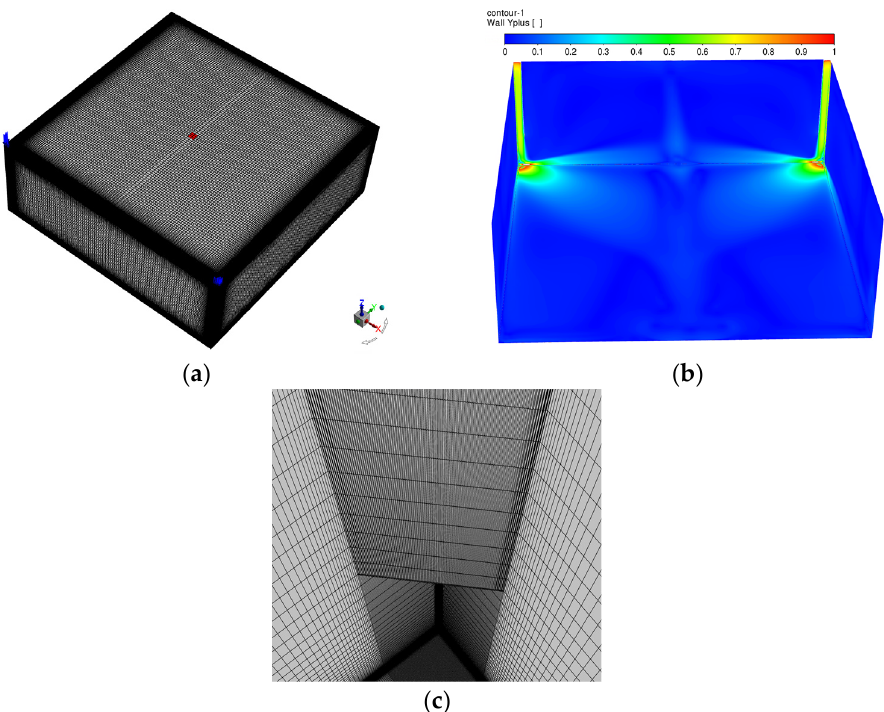
Figure 1. ( a ) Shows a perspective view over the room mesh where the two inlets are marked with blue and the outlet in the center is market with red. ( b ) Shows the y + distribution in the model. ( c ) Shows a more detailed view of the corner place